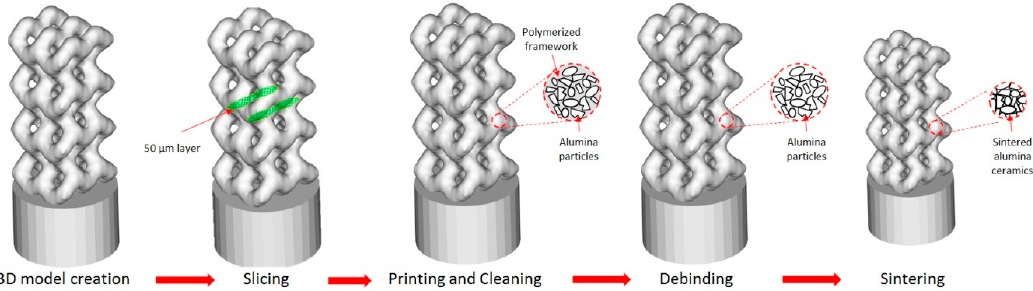
Figure 10. Fabrication of Al 2 O 3 ceramic implant at the Ceramaker 900 stereolithographic 3D printer.